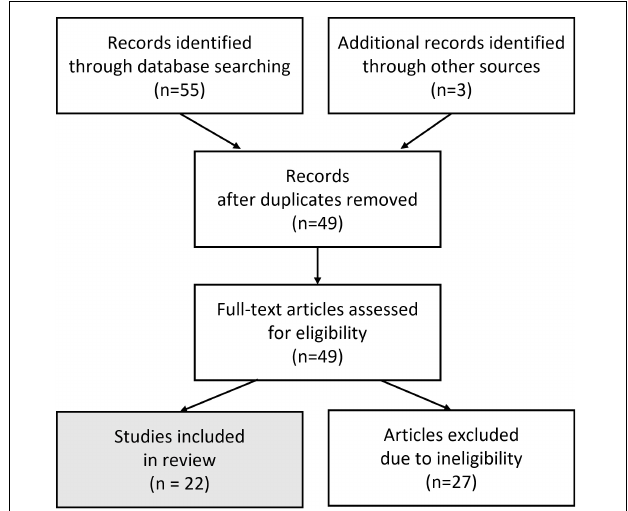
FIGURE 1 | A review flow chart, by following the Preferred Reporting Items for Systematic reviews and Meta-Analyses (PRISMA) guidelines (Page et al.,